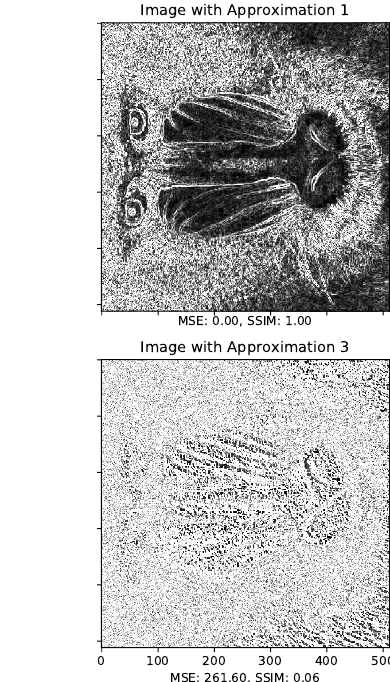
Figure 2. Sobel filter implementation with reduced data size and precision in hardware- implemented operators.